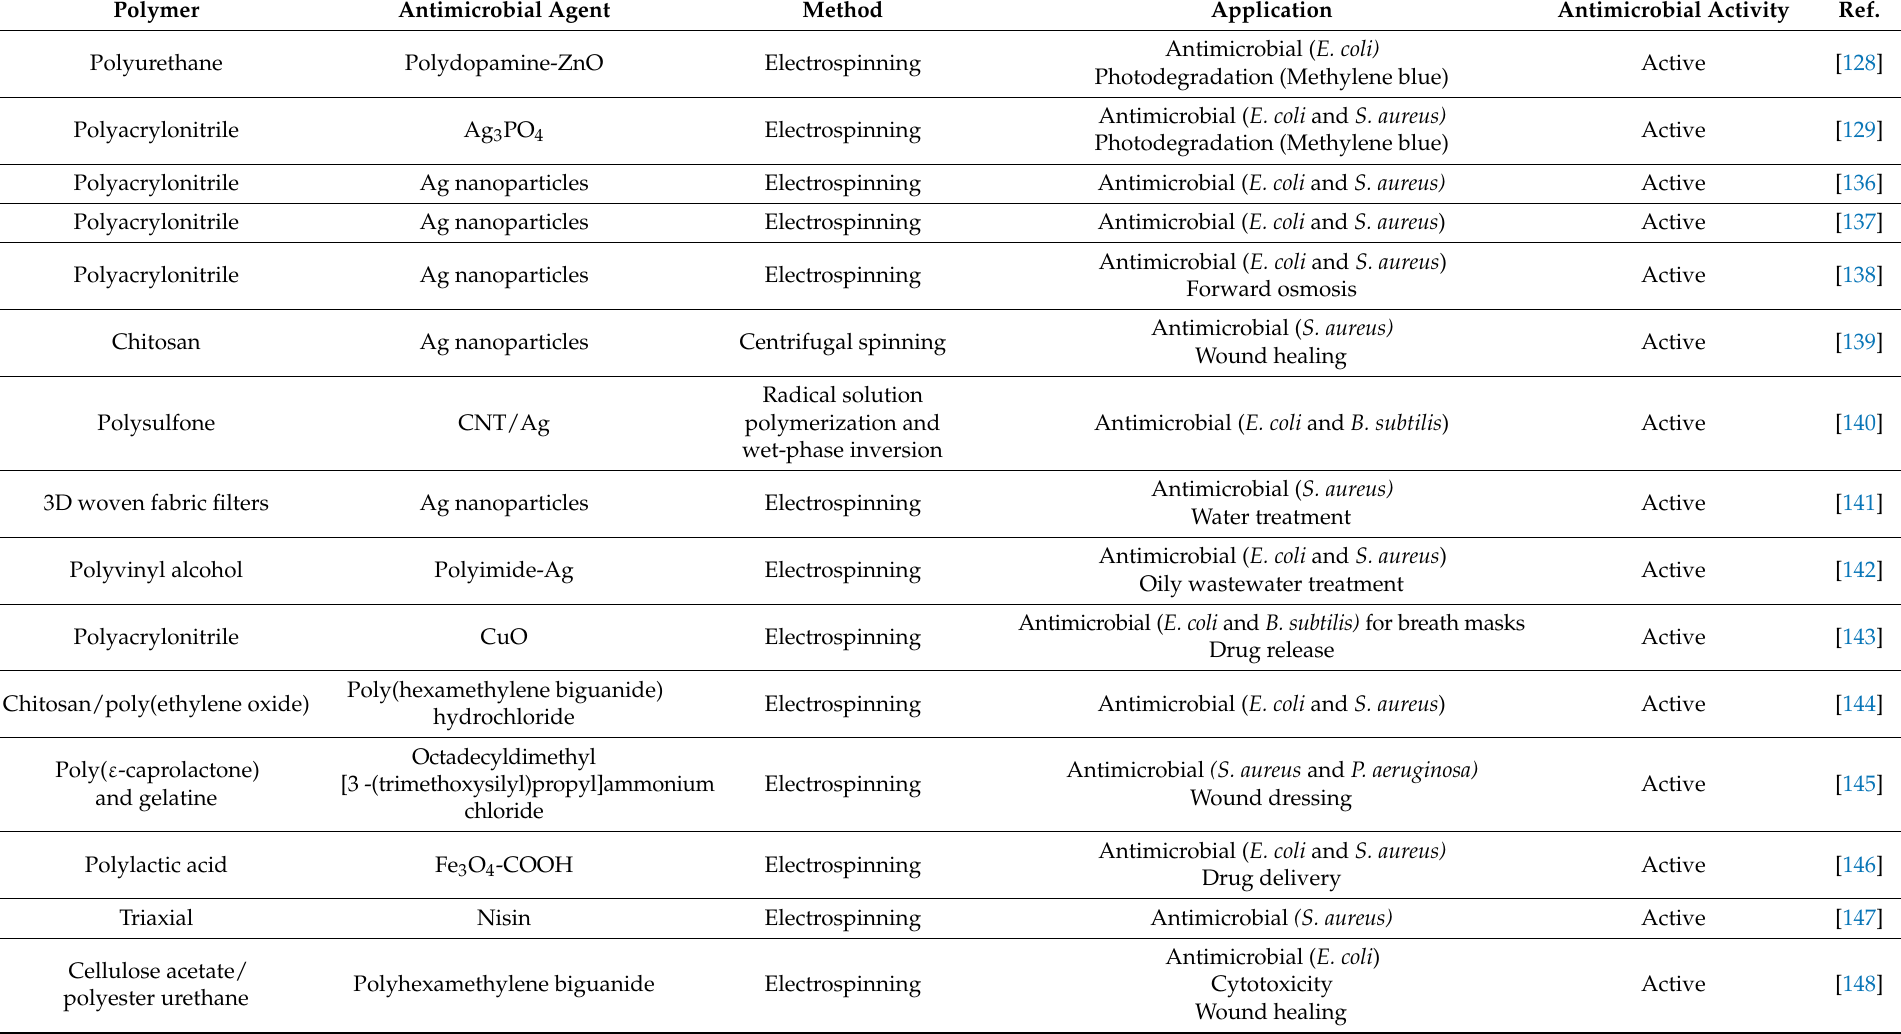
Table 3. Antimicrobial nanofiber membranes and their various